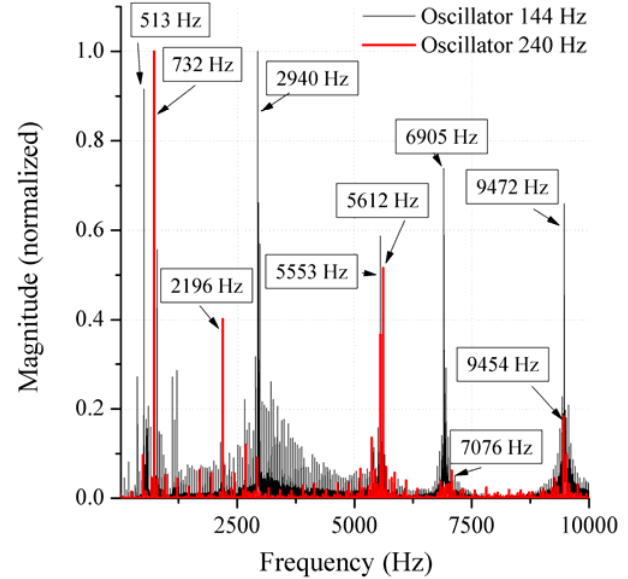
Figure 10. Frequency spectrum of the measurement using the demonstrator and exciting the oscillator type 144 Hz and type 240 Hz.